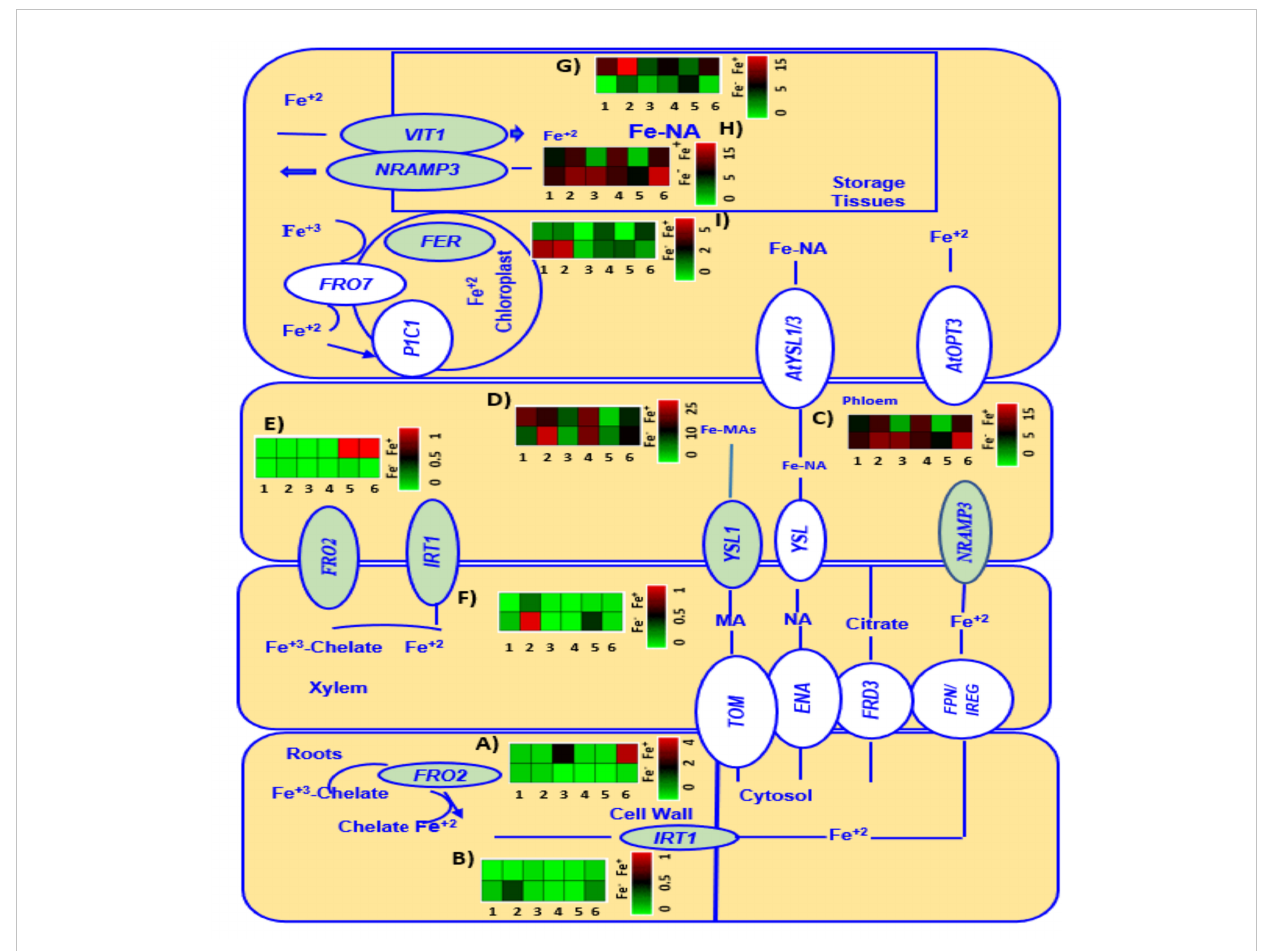
FIGURE 5 A heatmap analysis showing the gene expression patterns of Fe metabolism related genes FRO2 (A, E) , IRT1 (B, F) , NRAMP3 (C, H) , YSL1 (D) , V1T1 (G) , and FER3 (I) in roots and leaves of six genotypes (1 = CDC Verano, 2 = Cermi 075, 3 = FLIP97-677C, 4 = Sarik 067, 5 = Kalka 064, and 6 = CDC 551- 1). The data at V3 growth stage was taken from both Fe zero (Fe - ) and Fe added (Fe + ) conditions. Green and red color represents down-regulation, and up-regulation in the color scale,